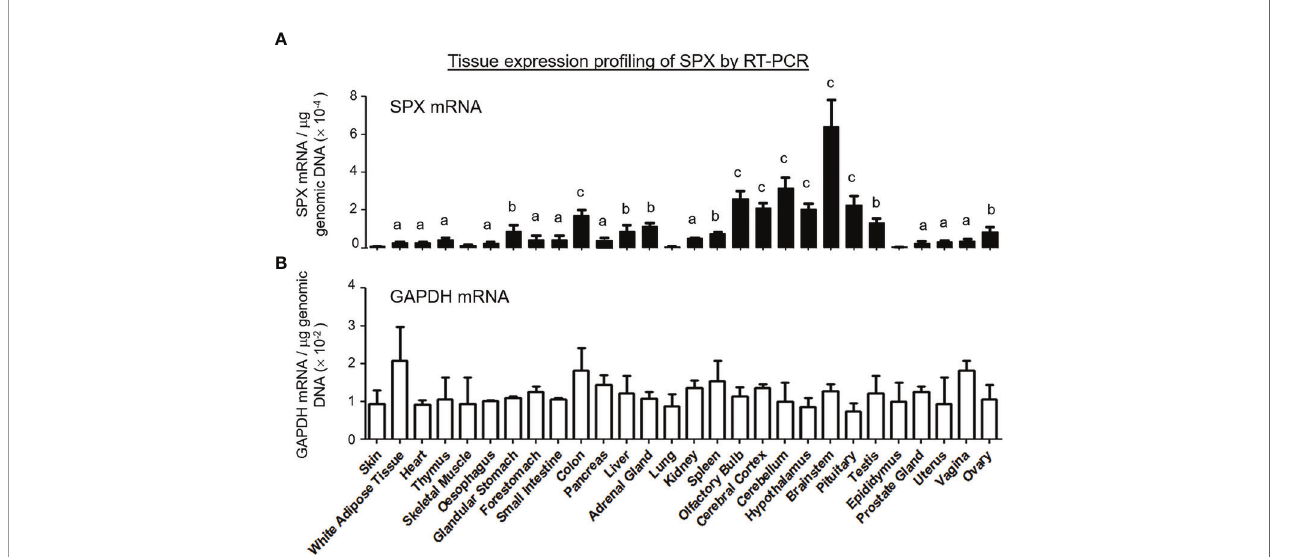
FIGURE 3 | Tissue distribution of SPX expression by RT-PCR. A total of 28 tissues were harvested from the mouse, reversely transcribed and subjected to real-time PCR with primers speci fi c for mouse SPX. (A) The data for SPX transcript were normalized with genomic DNA obtained in the same sample during the process of RNA isolation to adjust for variations in the amount of tissue used in sample preparation. Parallel PCR for GAPDH with similar data normalization was also conducted to serve as the internal control. (B) The groups denoted with different letters (a, b, c) represent a signi fi cant difference ( P < 0.05, Student ’ s t test, N = 5) in SPX gene expression compared to the skin (the tissue with the lowest level of SPX expression as a reference for comparison). In this study, GAPDH expression in tissues examined did not exhibit signi fi cant difference compared to the skin. (Grouping of SPX expression: No label, no difference vs the skin; (a) ≤ 5 fold higher than the skin; (b) between 5 to 10 fold higher than the skin; (c) ≥ 10 fold higher than the